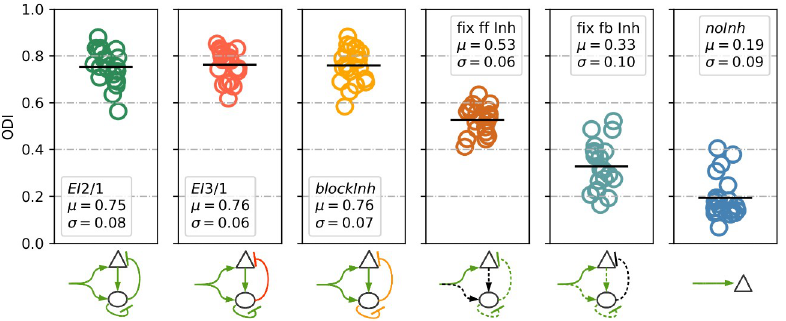
Fig 3. Tuning diversity is improved by plastic feed-forward and feedback inhibition. The orientation diversity index ( ODI ) is calculated via the Kullback-Leibler divergence between an idealized orientation distribution and the measured distribution in the network. The exponential of the divergence value is taken, so that higher values indicate a more uniform orientation distribution. Green arrows indicate plastic synapses, black arrows denote fixed synapses. Orange arrows indicate weaker synaptic connections. Dotted lines indicate that the model weights were initialized with shuffled values from weights of a previous run of the EI 2/1 model. The highest diversity of RFs is observed for all models with fully plastic inhibition during learning ( EI 2/1, EI 3/1, and blockInh models). Abolishing plasticity at feed- forward inputs to inhibitory neurons led to a moderate decrease of orientation diversity ( fixffinh model). Blocking plasticity at inhibitory feedback synapses onto excitatory neurons led to a stronger decrease in orientation diversity ( fixfbinh model). The lowest diversity was observed in the noInh model, were inhibition was fully absent.